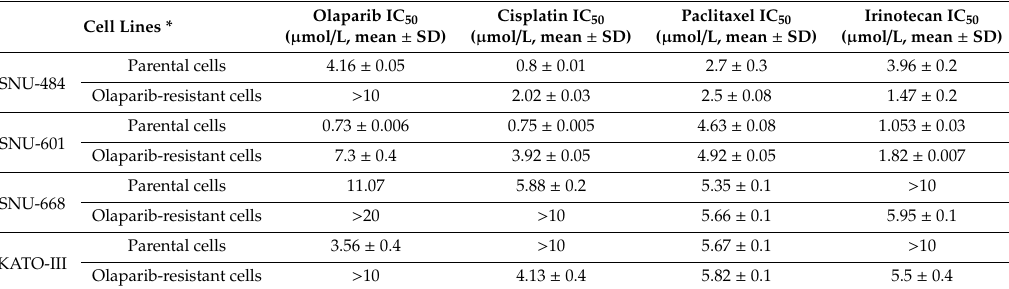
Drug sensitivity in parental and olaparib-resistant cells, as assessed by using cell growth-inhibition assay.